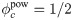
Statistics of mutant ΔtrkA strain.(A) We progressively incorporate into the model the on-cell fraction ϕ = 0.13 (light red), the exponential decay of ϕ in space with lengthscale λ = 7 cells (dark red), and the variability σϕ = 0.1 across lattices (green); N = 103 lattices for each. Resulting P(n) is a power law (green) despite the fact that 0.13 is far below the critical fraction ϕcpow=1/2. (B) P(n) from ΔtrkA data is a power law whose exponent is consistent with the model (N = 7 biofilms).